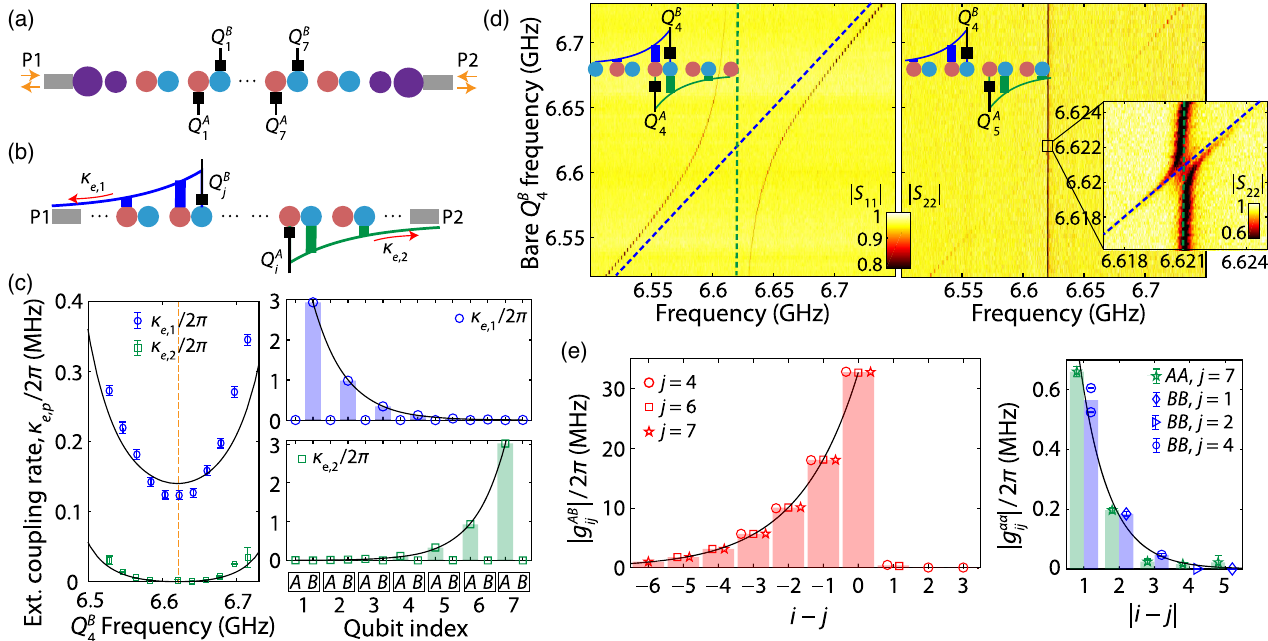
FIG. 2. Directionality of qubit-photon bound states. (a) Schematic of device I, consisting of 9 unit cells in the trivial phase with qubits (black lines terminated with a square) coupled to every site on the 7 central unit cells. The ends of the array are tapered with additional resonators (purple) with engineered couplings designed to minimize impedance mismatch at upper passband frequencies. (b) Theoretical photonic envelope of the directional qubit-photon bound states. At the reference frequency ω 0 , the qubit coupled to site A ( B ) induces a photonic envelope to the right (left), colored in green (blue). The bars along the envelope indicate photon occupation on the corresponding resonator sites. (c) Measured coupling rate κ to external port numbers, p ¼ 1 , 2, of qubit-photon bound states. e;p Left: external coupling rate of qubit Q B 4 to each port as a function of frequency inside the MBG. Solid black curve is a model fit to the measured external coupling curves. The frequency point of highest directionality is extracted from the fit curve, and is found to be ω 2 π ¼ 6 . 621 GHz (vertical dashed orange line). Top (Bottom), right: external coupling rate of all qubits tuned to ω ¼ ω 0 = 0 measured from port P1 (P2). The solid black curves in these plots correspond to exponential fits to the measured external qubit coupling versus qubit index. (d) Two-dimensional color intensity plot of the reflection spectrum under crossing between a pair of qubits with frequency centered around ω ¼ ω 0 . Left: reflection from P1 ( j S 11 j ) while tuning Q B 4 across Q A 4 (fixed). An avoided crossing of 2 j g AB 44 j = 2 π ¼ 65 . 7 MHz is observed. Right: reflection from P2 ( j S 22 j ) while tuning Q B 4 across Q A 5 (fixed), indicating the absence of appreciable coupling. Inset to the right shows an enlarged region where a small avoided crossing of 2 j g AB 54 j = 2 π ¼ 967 kHz is measured. The bare ; Q β ) at qubit frequencies from the fit are shown with dashed lines. (e) Coupling j g αβ j ( α ; β ∈ f A; B g ) between various qubit pairs ( Q α ij j i ω ¼ ω 0 , extracted from the crossing experiments similar to (d). Solid black curves are exponential fits to the measured qubit-qubit coupling rate versus qubit index difference (spatial separation). Error bars in all panels indicate 95% confidence interval, and are omitted on data points whose marker size is larger than the error